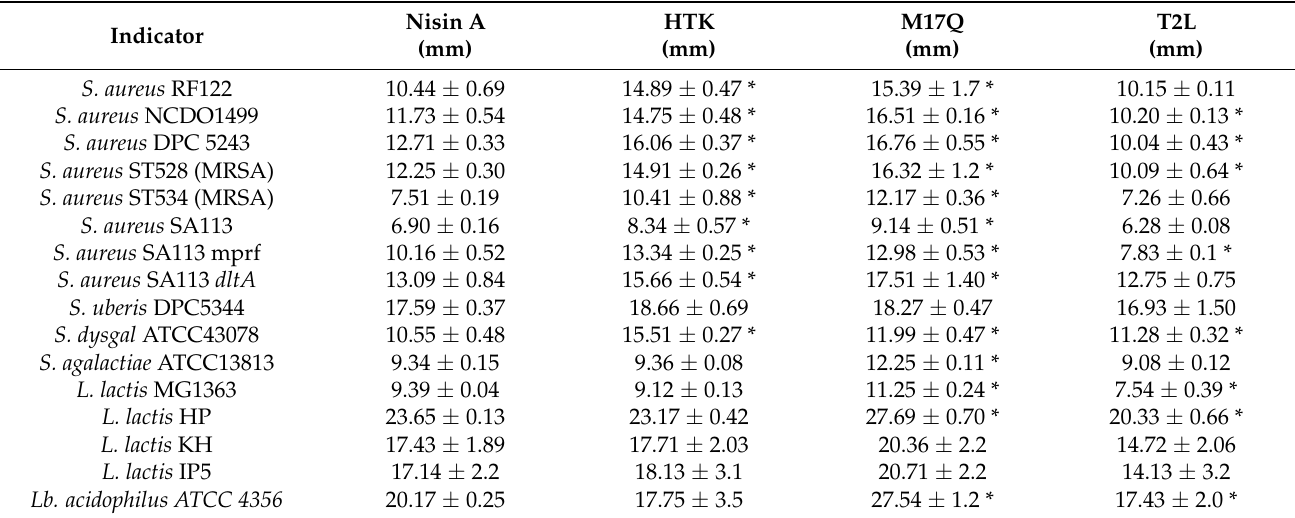
Table 1. Bioactivity of nisin and nisin variant producers against representative bovine-mastitis associated strains and dairy lactococci strains. Values given are the mean of triplicate deferred antagonism assays where the diameter of the zone of inhibition is in mm. Asterisk denotes statistical significance compared to nisin A ( p < 0.05).